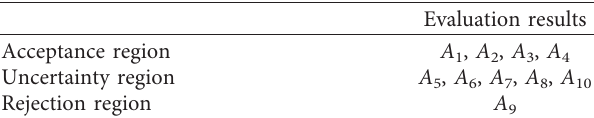
Table 6: The evaluation results by the developed hidden property evaluation